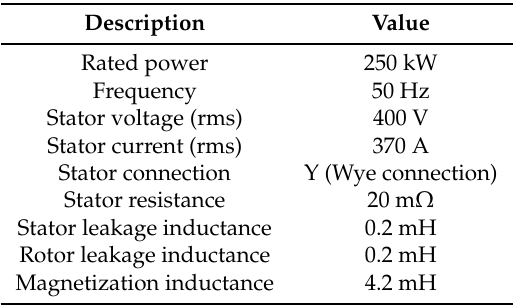
Table 2. Features of simulated DFIG. DFIG: doubly-fed induction generator.